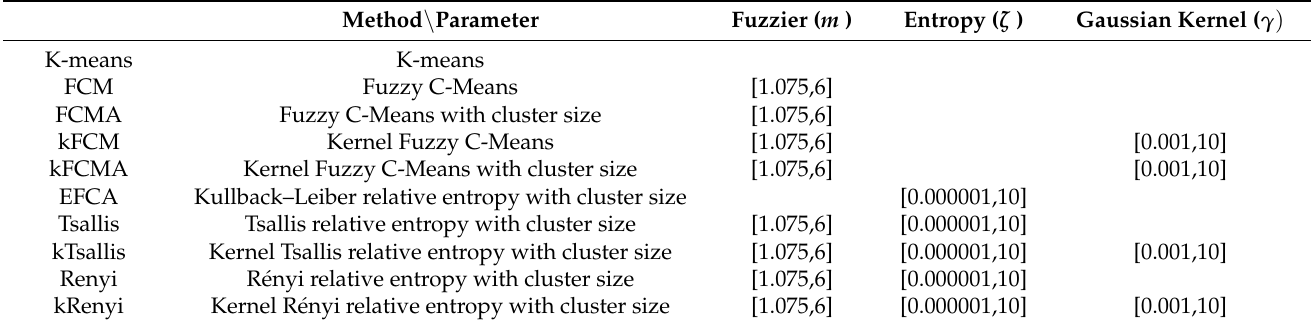
Table 1. The range of values of the parameters of each method.